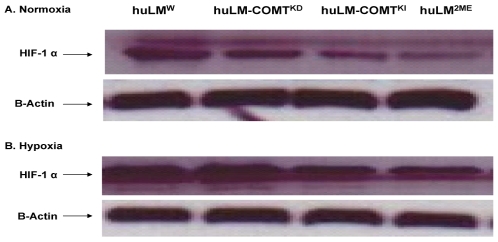
Effect of COMT expression or treatment with 2ME (500 nM) on basal and hypoxia-induced HIF-1α protein levels in huLM.(A) Western blot analysis of basal level of HIF-1α in whole cell extracts from huLMW; huLM 2-ME, huLM-COMTKD, and huLM-COMT.KI (B) HIF-1α level in huLMW; huLM 2ME; huLM-COMTKD; and huLM-COMTKI incubated for 8 h with CoCl2 (100 µM).